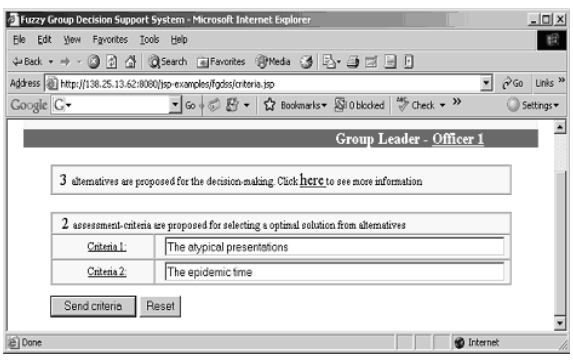
Fig. 3. The criteria proposed by Officer